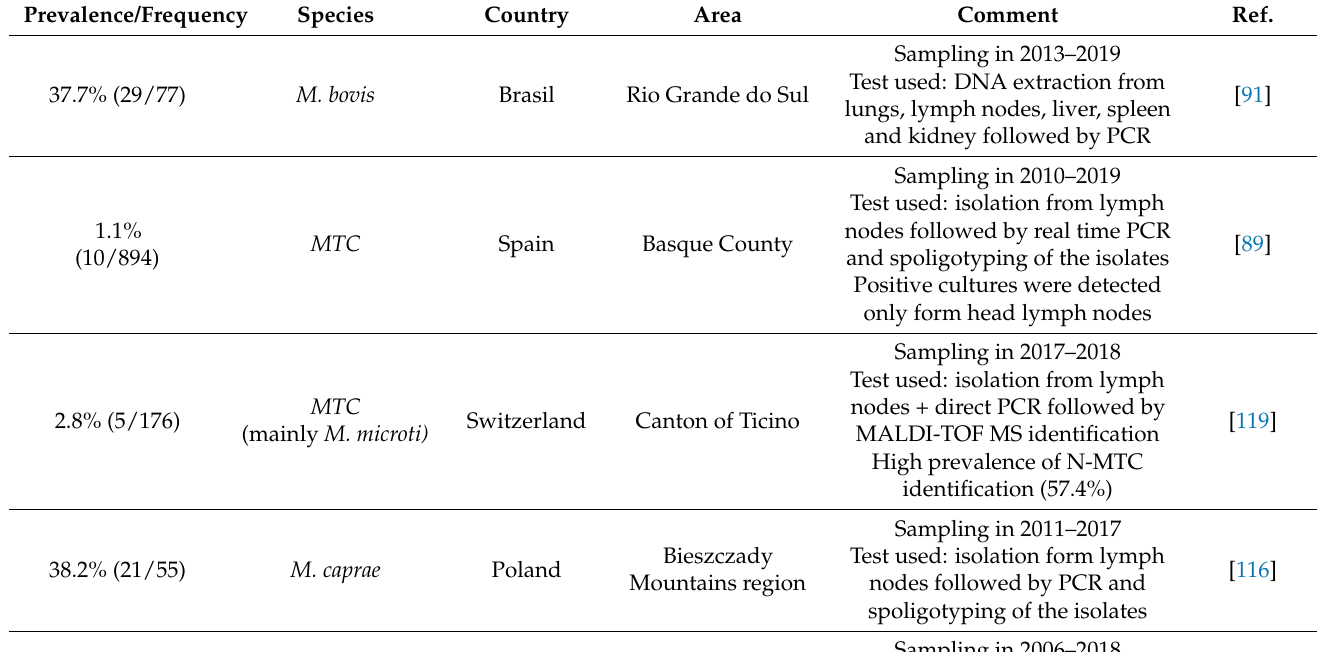
Table 8. Prevalence of Mycobacterium spp. in wild boar, feral pigs and warthog organs and tissues,